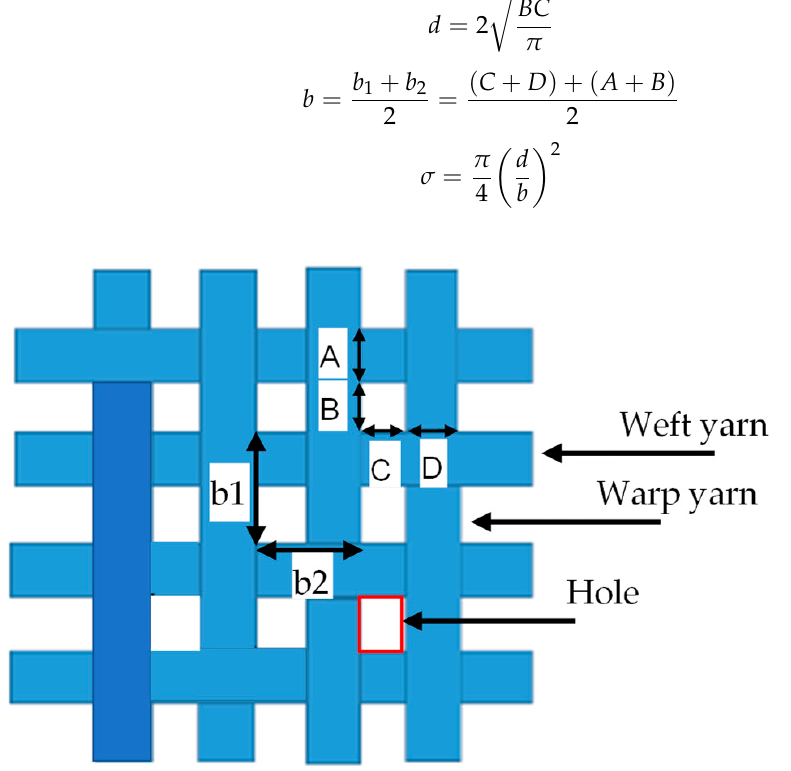
Figure 2. Geometrical hole parameters of twill 3/1 structure.